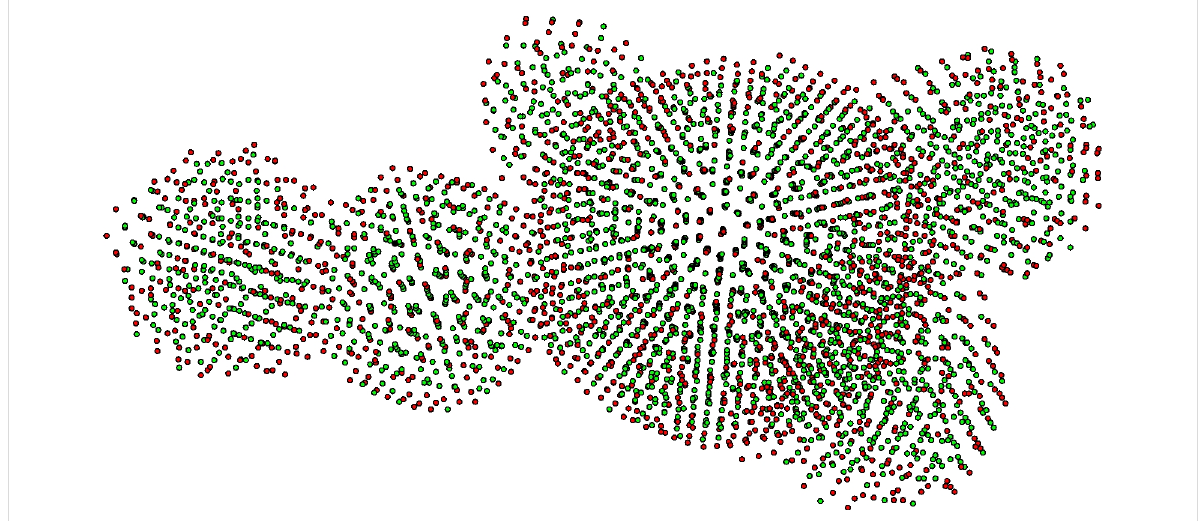
Figure 4: Image of a Cu 60 Au 40 nanoparticle obtained by MD modeling. Copper atoms are shown in green and gold atoms are shown in red.